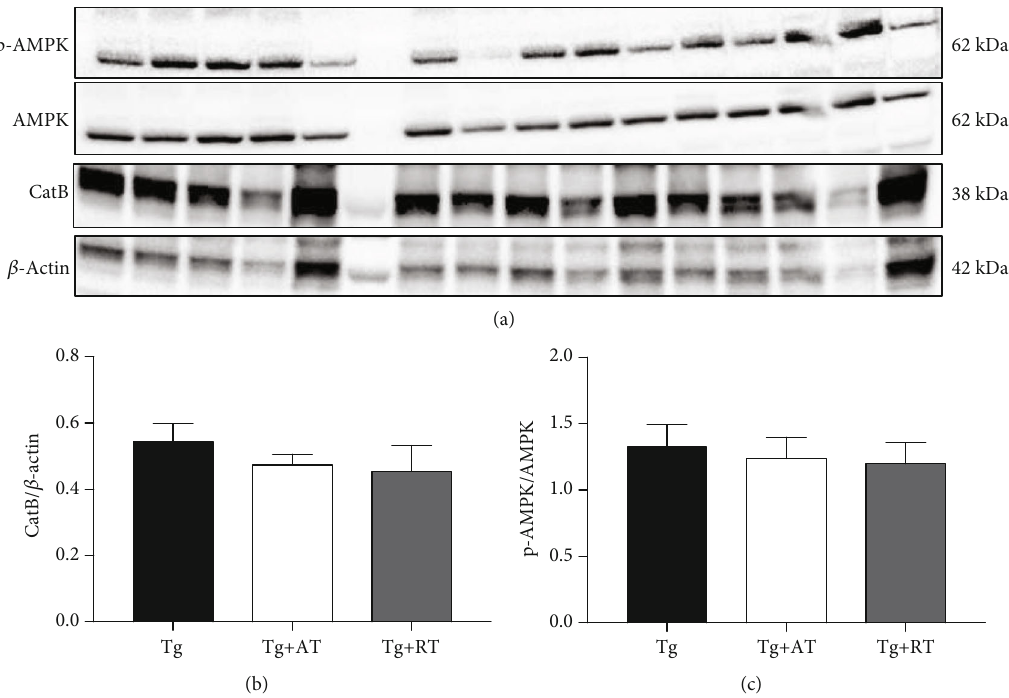
Figure 2: Unaltered AMPK activation and cathepsin B (CatB) expression in skeletal muscle of exercise-trained 3xTg-AD mice. (a) Immunoblots for CatB, p-AMPK, and AMPK in skeletal muscle homogenate. (b) CatB expression normalized to β -actin. (c) p-AMPK expression normalized to total AMPK. Data presented as mean ± SE . Tissues assayed from the nonexercised group (Tg), the aerobic- trained group (Tg+AT), or the resistance-trained group (Tg+RT) ( n = 10 /group). Di ff erences determined by one-way